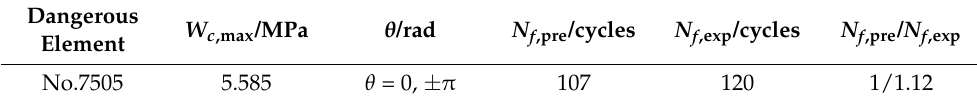
considers the strain energy consumed in the crack growth plane and has more considerable accuracy than the SED. Table 3. Comparison between predicted fatigue life and measured life of the flexible joint.